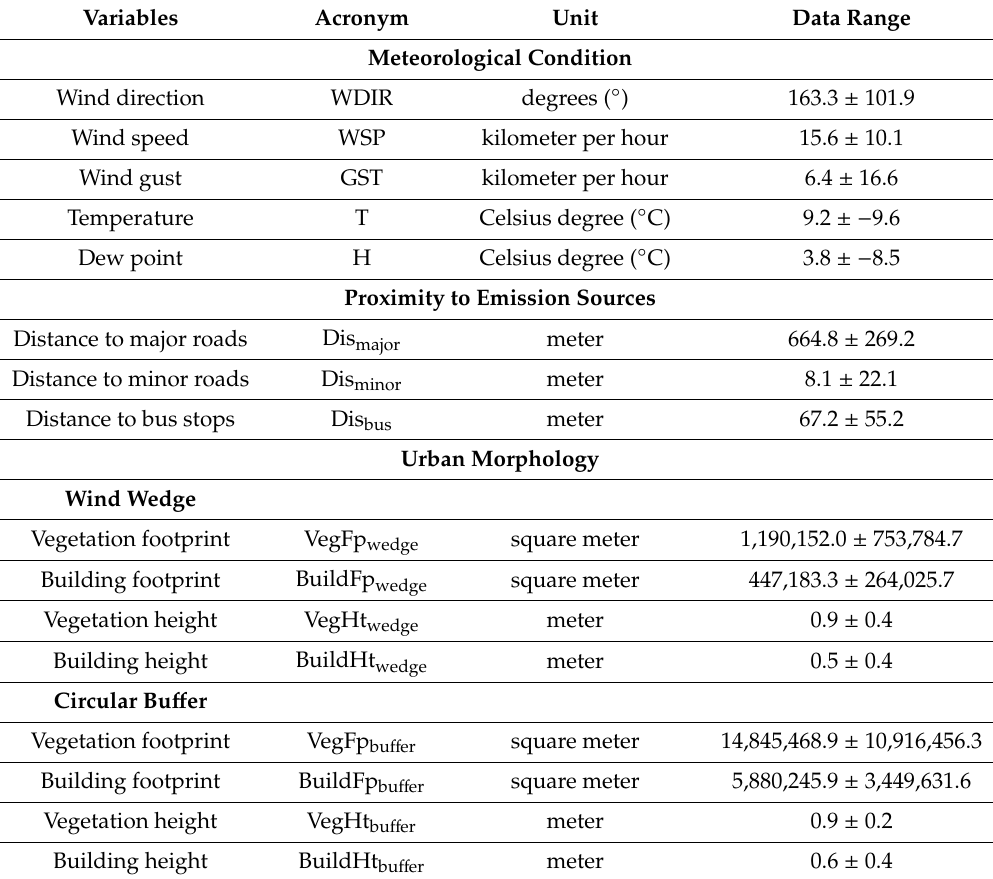
Table 1. List of the explanatory variables and their descriptive